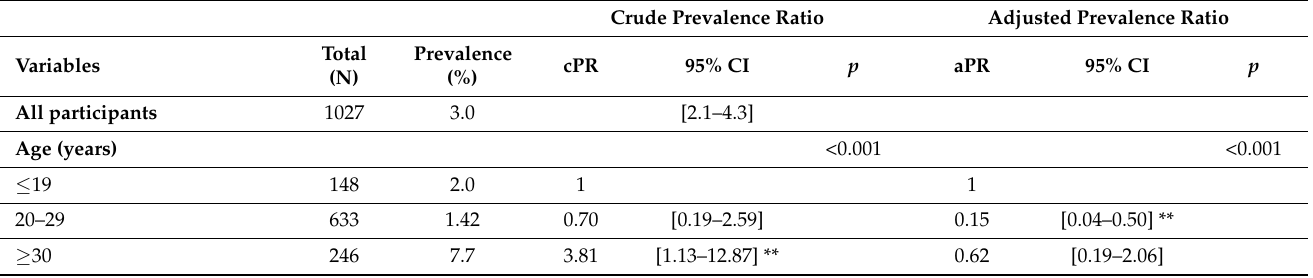
Table 3. Tobacco use among pregnant women and associated factors in rural and semi-urban Burkina Faso, 2019; (Crude, adjusted prevalence ratio, and 95%